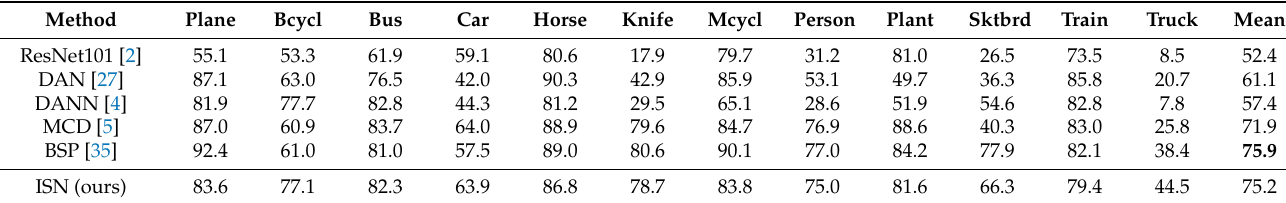
Table 3. Accuracy (%) on VisDA-2017.